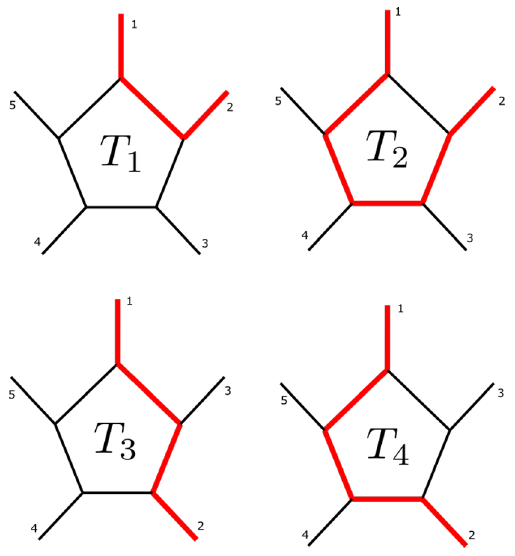
Figure 2 . The four distinct one-loop integral topologies appearing in the pp → t ¯ tj amplitudes. Black lines denote massless particles while red lines denote massive